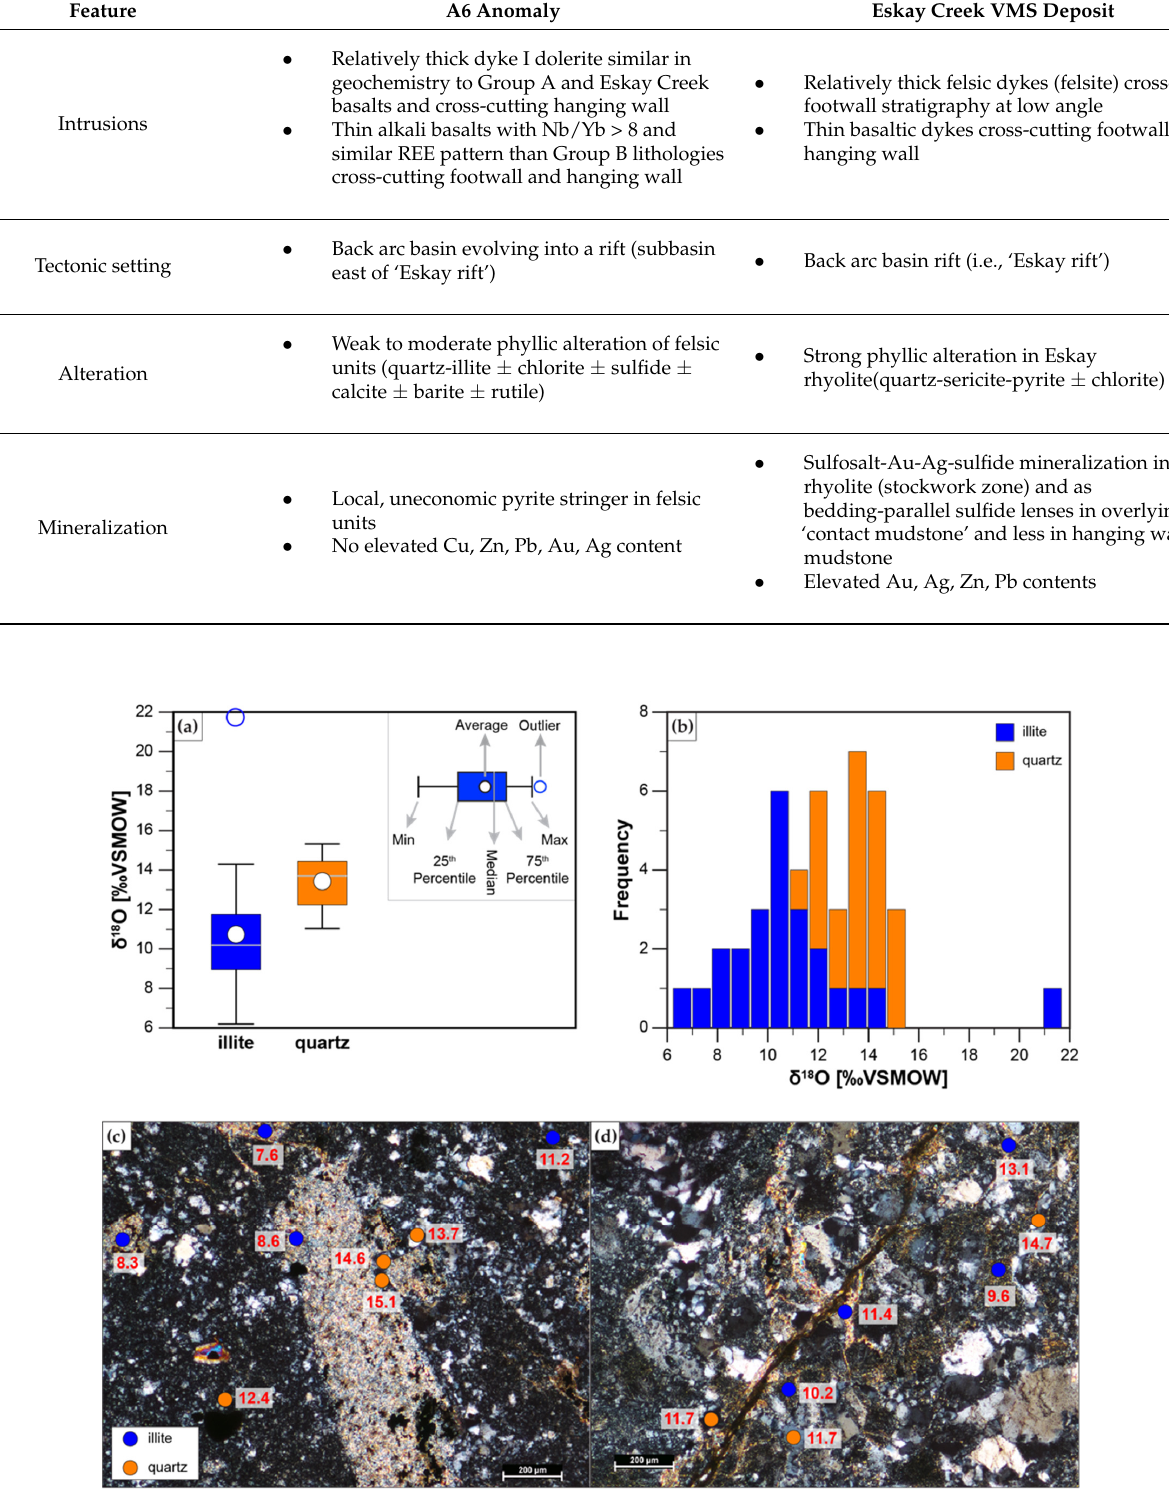
Figure 19. Oxygen isotope composition of illite and quartz in altered flows, ( a ) Tukey box-whisker plot showing range of δ 18 O composition in both phases, ( b ) histogram (bin width 0.775‰), ( c ) δ 18 O values of illite completely replacing plagioclase phenocryst, quartz surrounding feldspar pseudomorph, and fine-grained quartz-illite matrix (sample S825792, BR-79), ( d ) δ 18 O values of illite in fine stringer and within altered matrix and relatively fine- to coarse-grained quartz in vicinity of illite (sample S826793, BR-82).